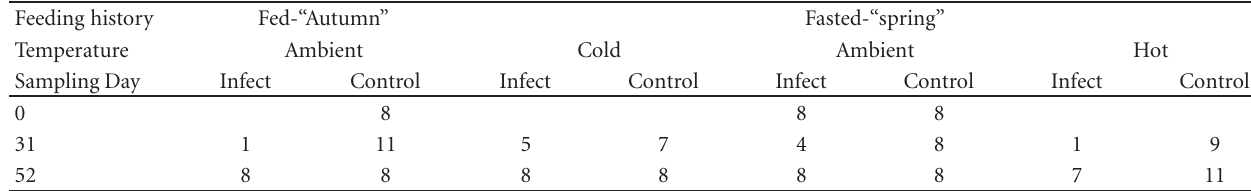
Table 1: Sample sizes of juvenile Pacific herring for proximate composition analysis by temperature, where Infect = infected and Control =